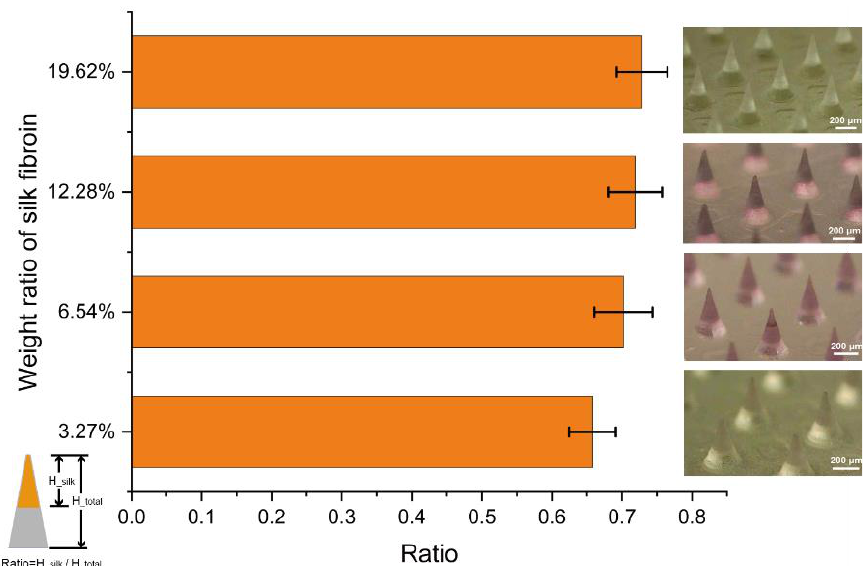
Figure 3. The change of the ratio of tip and base: the picture in the left shows the comparison of the ratio of silk fibroin tips between microneedle array patches with different weight ratios of silk fibroin. The pictures in the right are the microneedle arrays with the corresponding weight ratios of silk fibroin under a stereomicroscope, where color difference is due to the background difference.